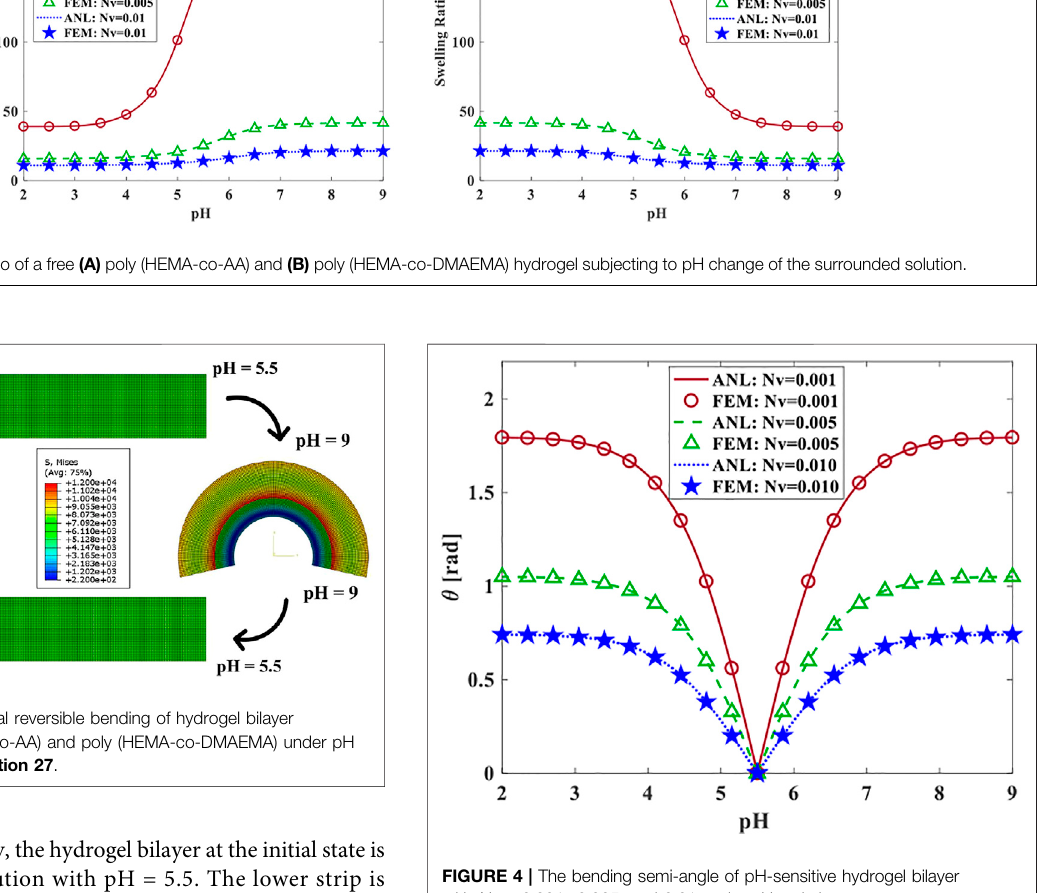
FIGURE 4 | The bending semi-angle of pH-sensitive hydrogel bilayer with N ] (cid:1) 0 . 001 , 0 . 005 , and 0 . 01 under pH